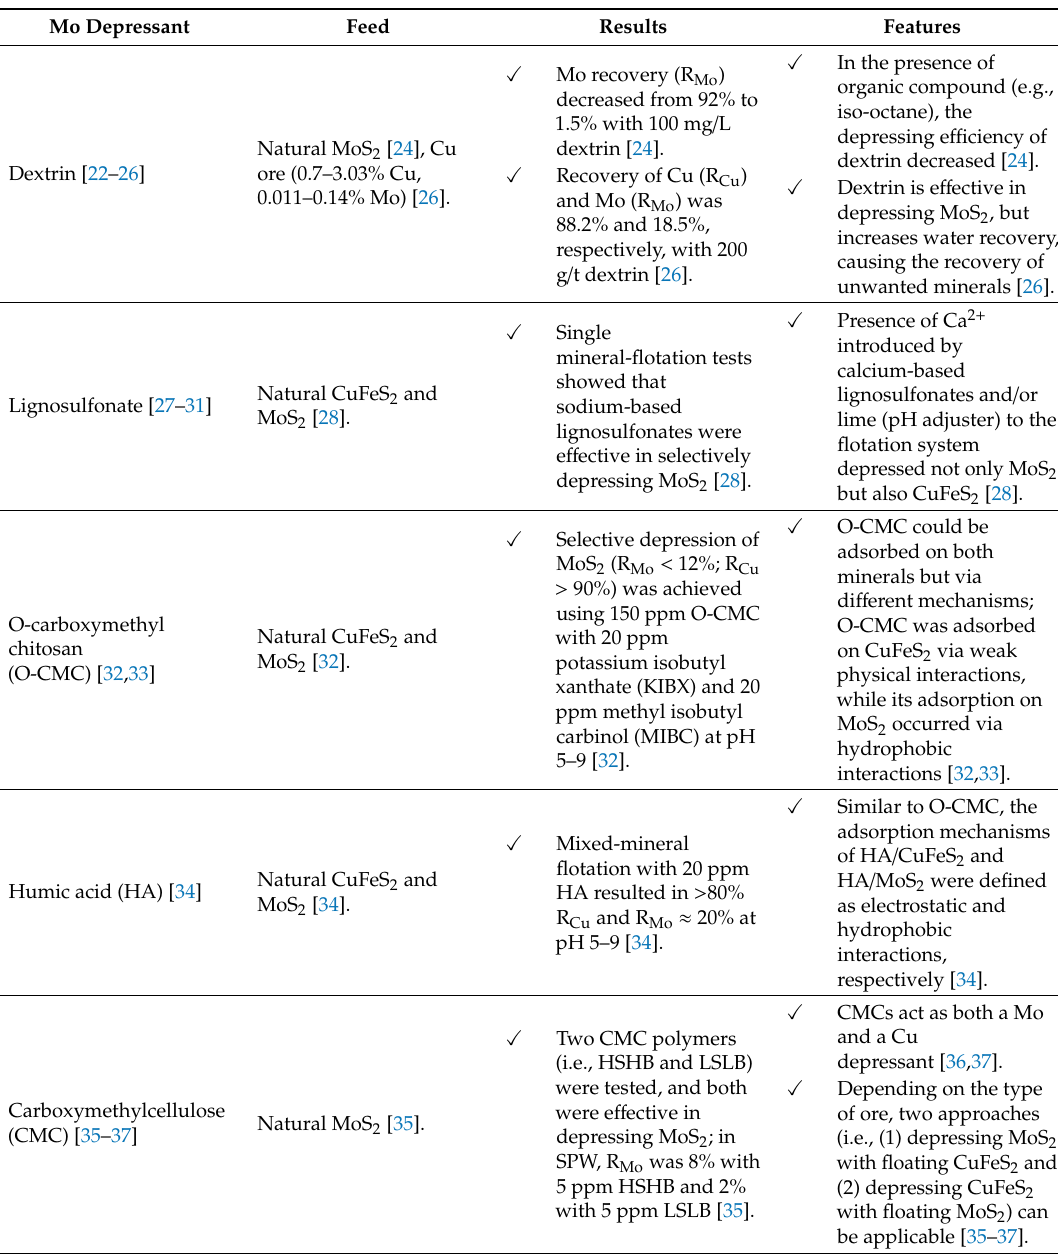
Table 1. Summary of molybdenite